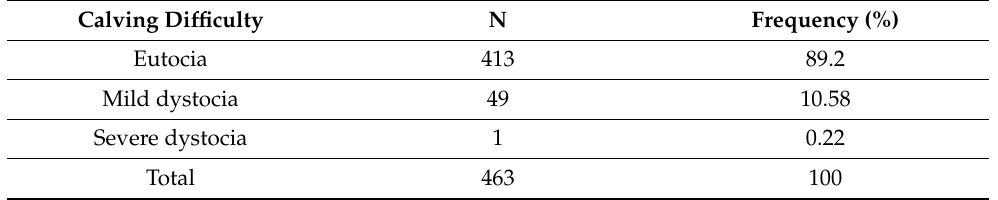
Table 2. Frequency of calving